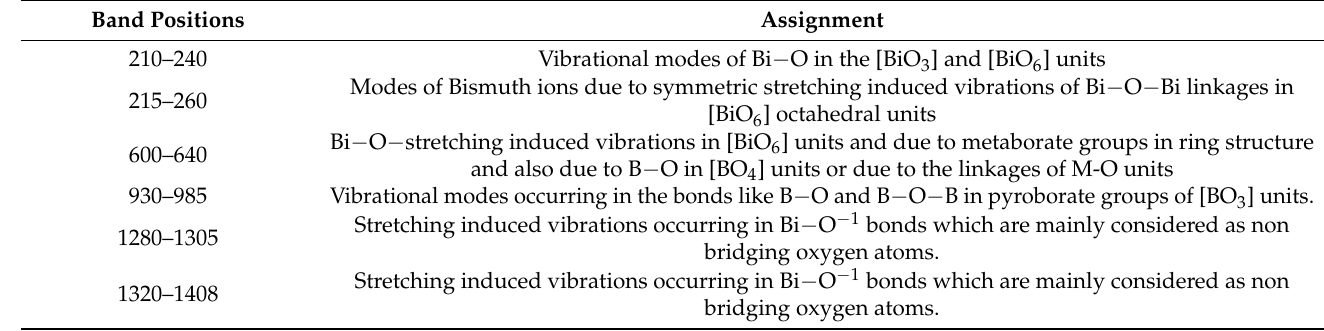
Figure 5. Raman spectra of the BiBLM glasses. Table 4. Raman band assignment of BiBLM